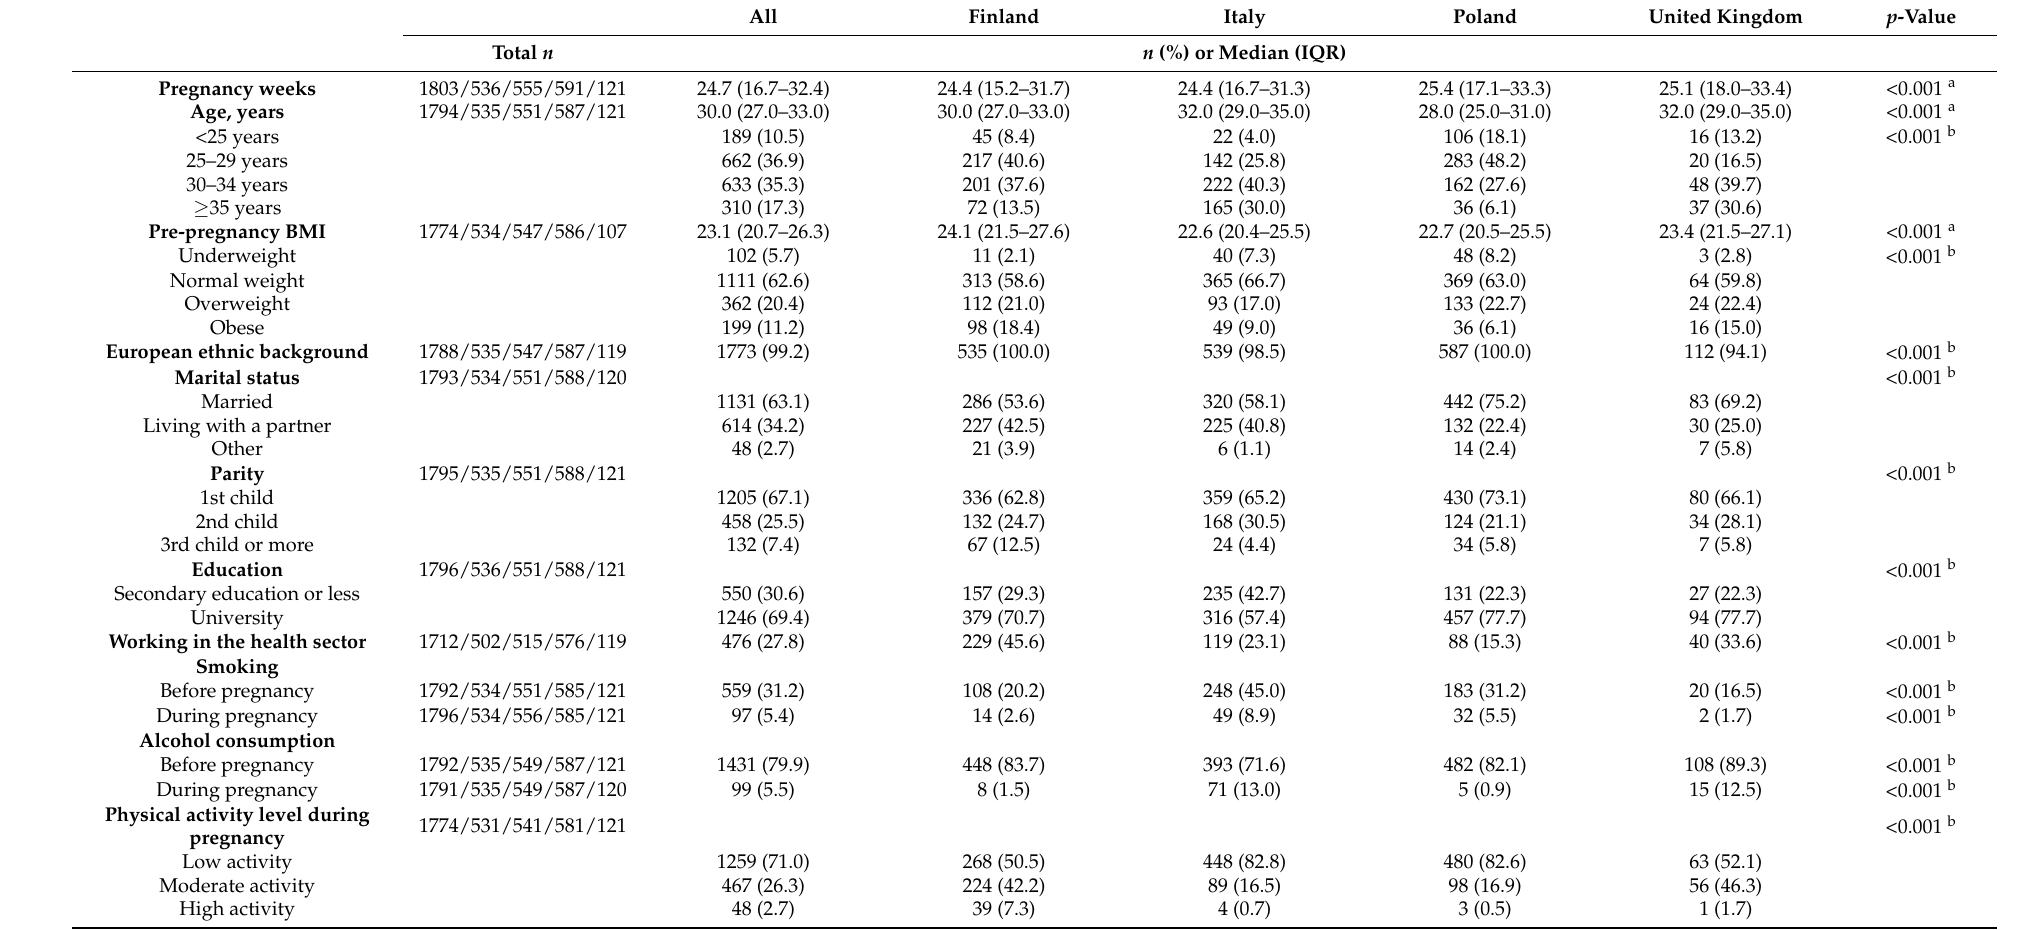
Table 1. Characteristics of the pregnant women participating in the study ( n =